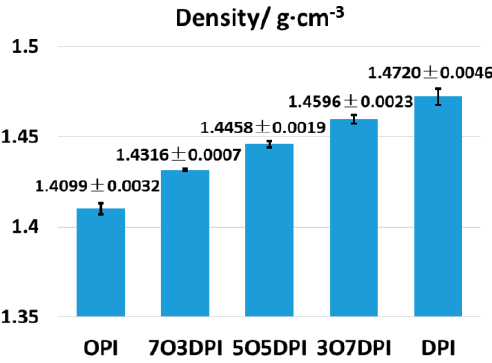
Figure 4. Density data of the polyimide films.